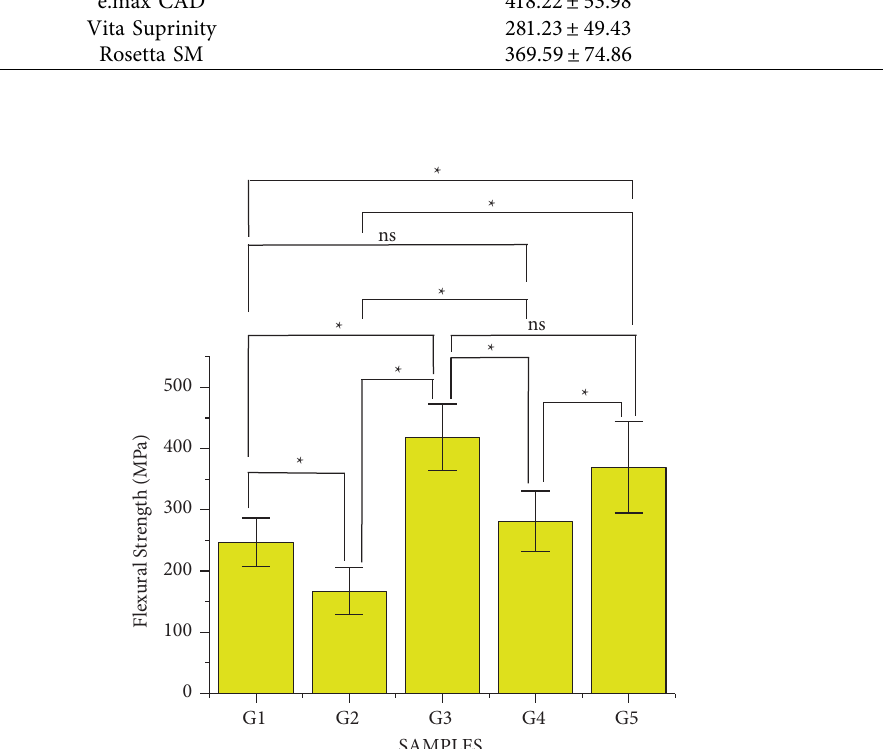
Figure 3: Bar graph of the flexural strength of ceramics. Analysis of variance with Tukey’s multiple comparison test was used to compare the flexural strength of the ceramics in this study. The ( ∗ ) represents the significant difference between the groups, and (ns) represents the nonsignificant values.